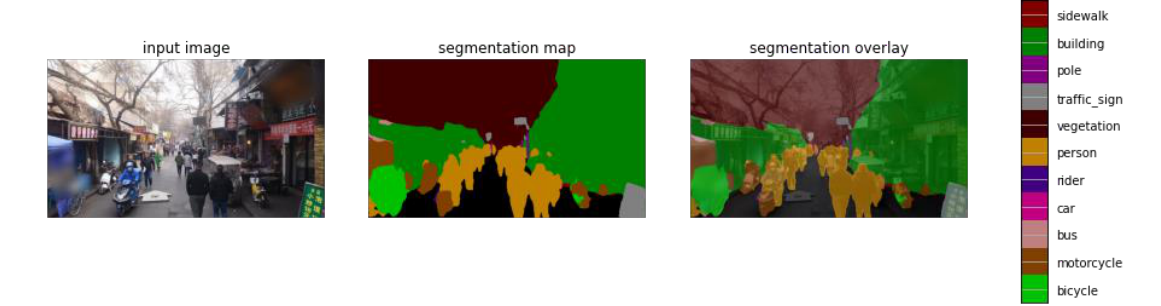
Figure 3. Sample of segmentation map before pandemic in 2019 (No. 38).